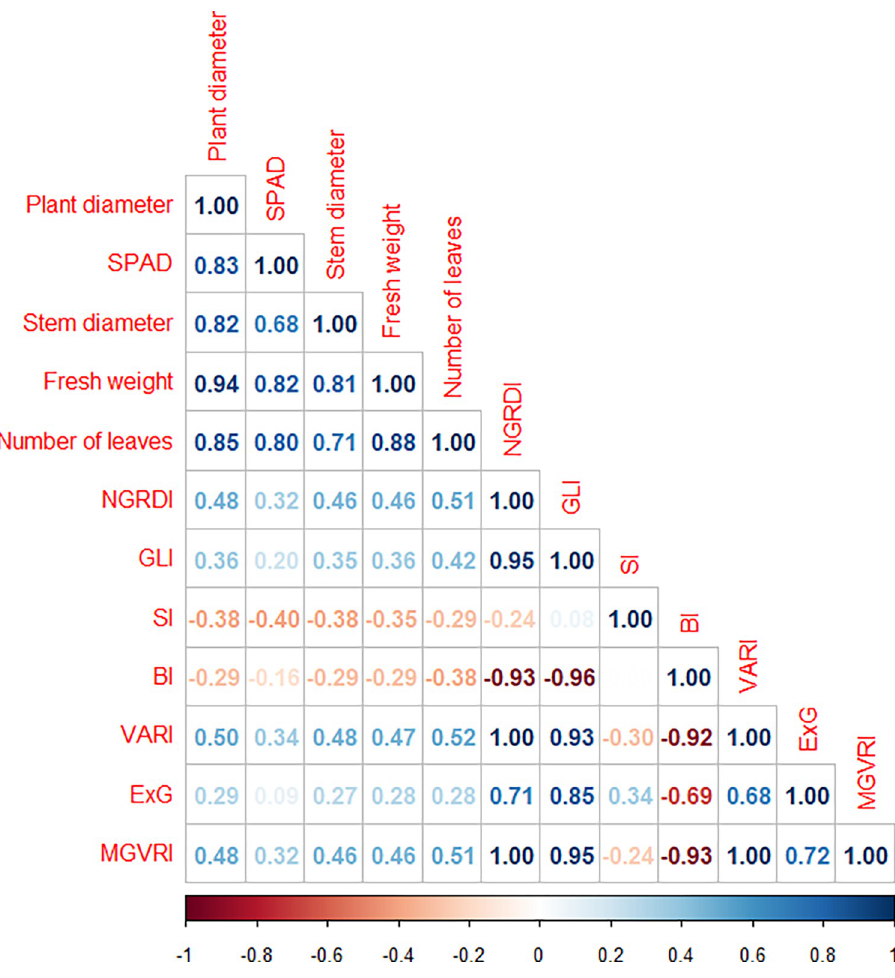
Fig 5. Pearson’s correlation matrix between plant growth parameters and vegetation indices. Positive and negative correlations are shown in blue and red tones, respectively. NGRDI: Normalized Green Red Difference Index, GLI: Green Leaf Index, SI: Soil Color Index, BI: Brightness Index, VARI: Visible Atmospherically Resistant Index, ExG: Excess Green Index (ExG), and MGVRI: Modified Green Red Vegetation Index.